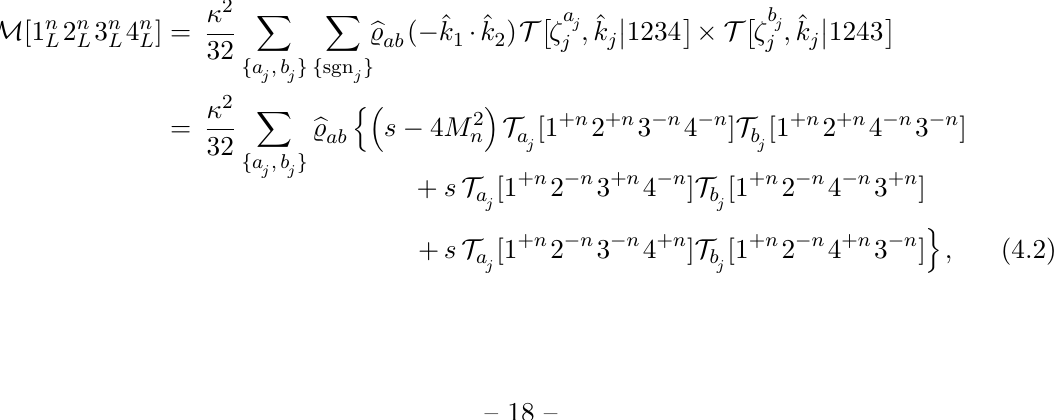
Figure 4 . Four-point scattering amplitude of massive KK closed-strings with Z (marked in blue) can be decomposed into a sum of the products of two color-ordered amplitudes of massive KK open-strings under the S 1 compactification of 26d for bosonic